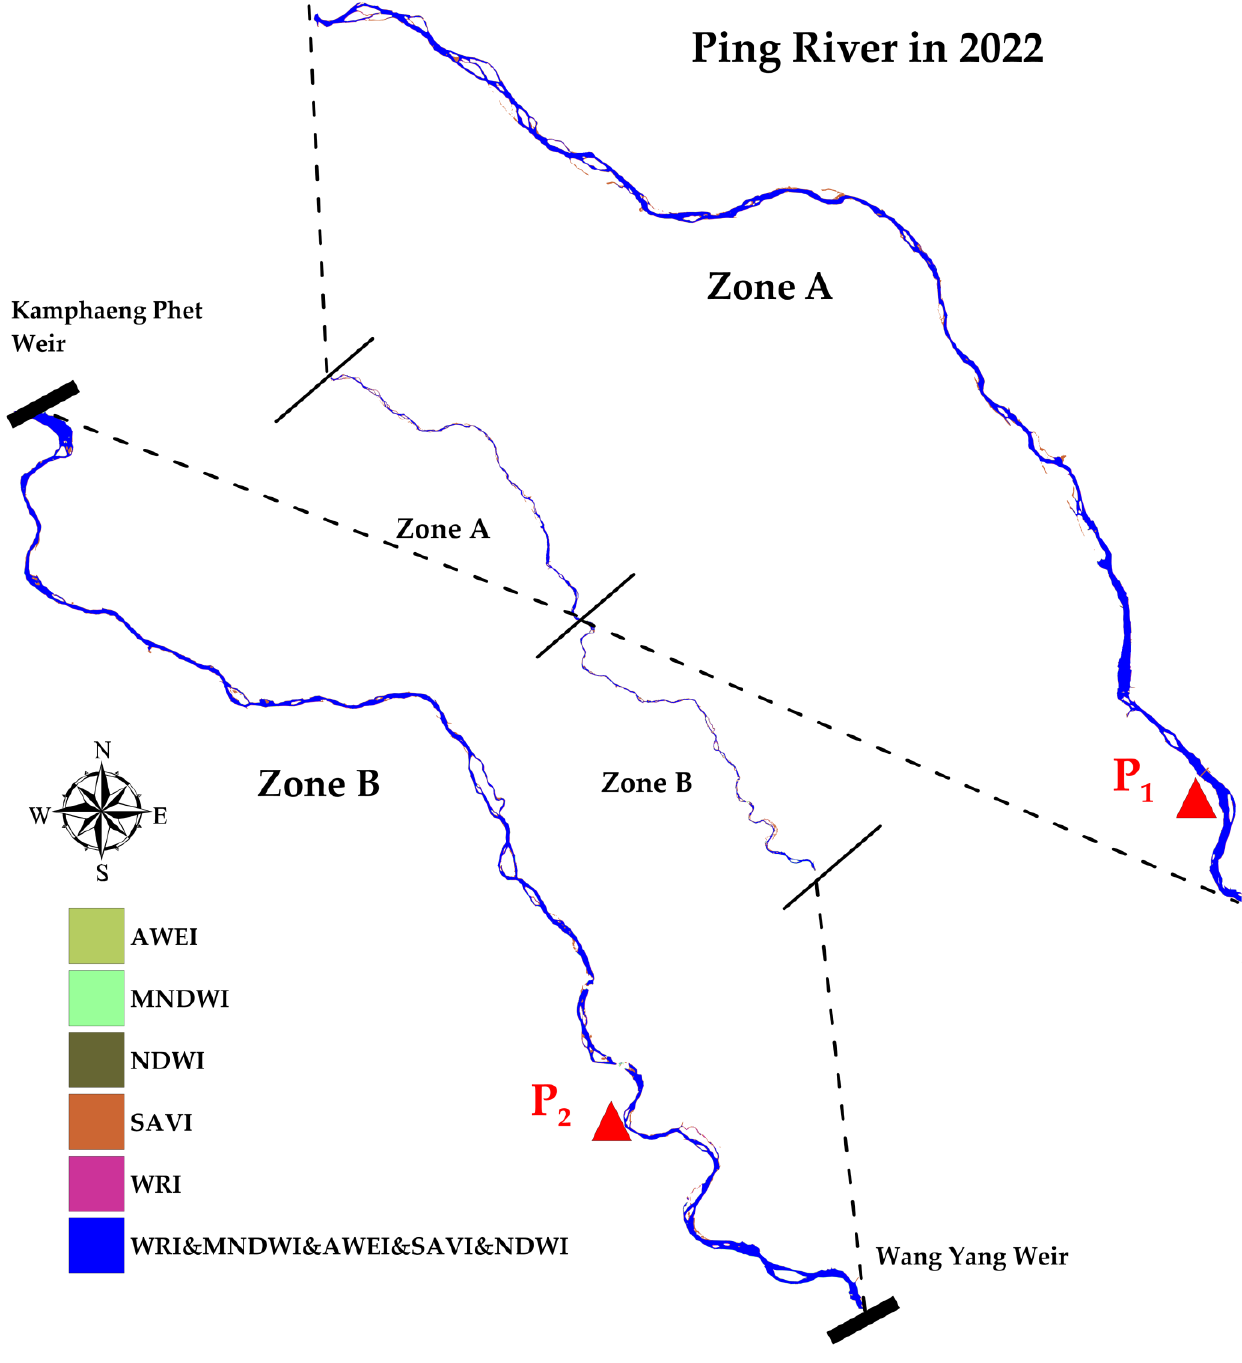
Figure 11. An overlay stream exists between NDWI, MNDWI, SAVI, WRI, and AWEI for 2022; Zone A is the upstream reach, and zone B is the downstream